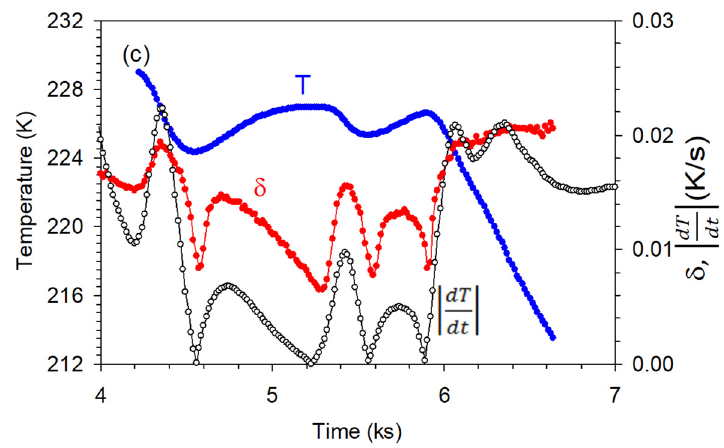
Figure 7. Temperature dependence of the internal friction for a Structure 1 sample with two a/c twin boundaries in a thermal cycle between 290 and 163 K, interrupted for 2400 s during cooling at 226 K and during heating at 200 K ( a ) and corresponding time dependences of temperature T, absolute value of cooling/heating rate dT/dt and the internal friction δ during the entire heating scan ( b ) and during interruption of cooling ( c ).